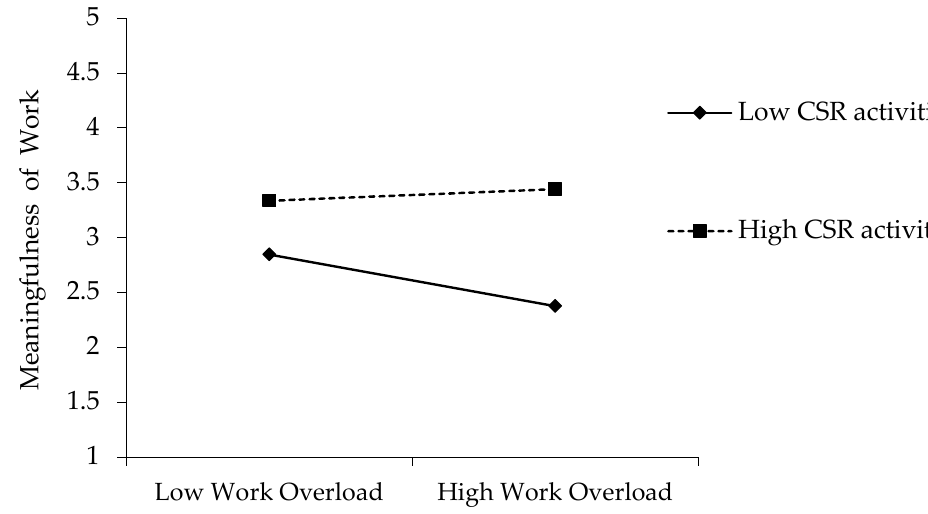
Figure 3 . Moderating Effect of CSR in the Work Overload–Meaningfulness of Work link . Figure 3. Moderating Effect of CSR in the Work Overload–Meaningfulness of Work